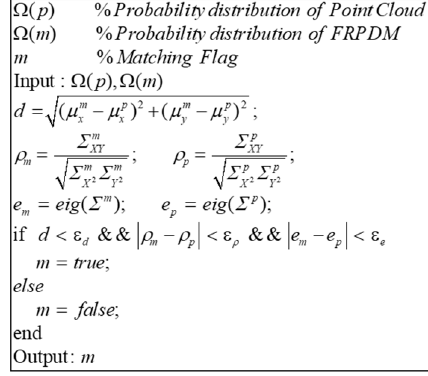
Figure 25. Pseudocode of probability distribution data association.